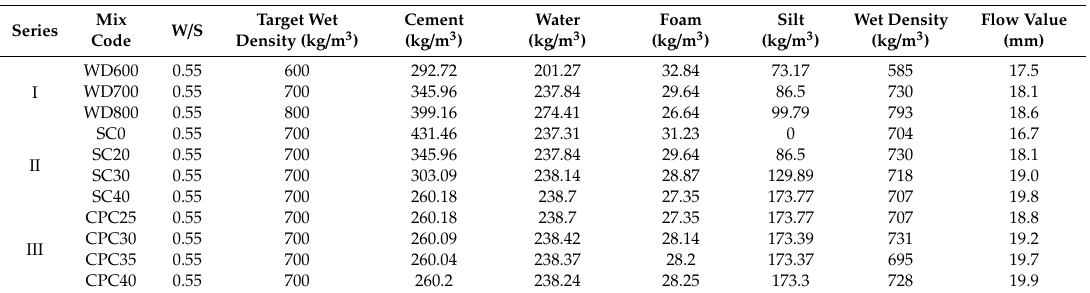
Table 5. Mixture compositions of foamed concrete. W / S—water-to-solid